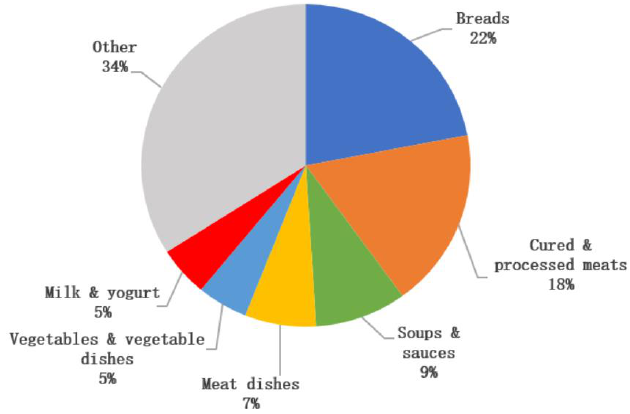
Figure 1. Key sources of sodium intake (excluding discretionary salt) in Irish adults. Nutrients 2020 , 12 , x FOR PEER REVIEW